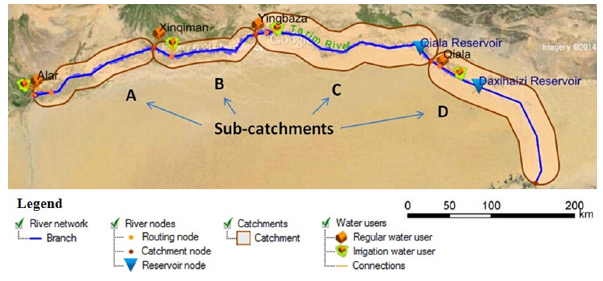
Figure 3. Aggregated sub-basins of the model MIKE HYDRO.